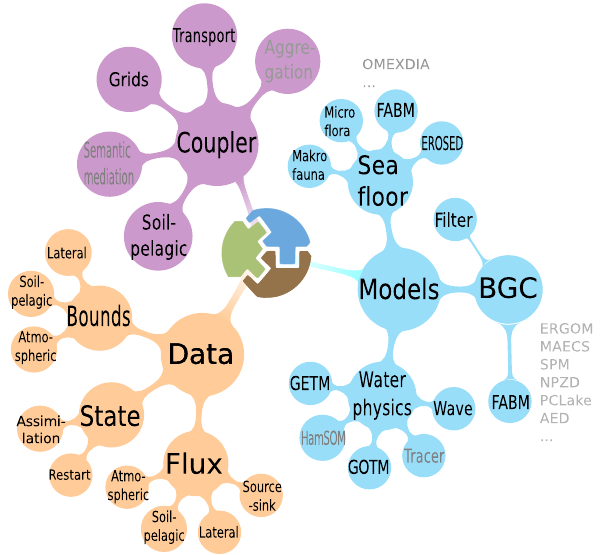
Figure 4. Modular components of MOSSCO. The blue branch col- lects newly created sub-models and components that wrap around legacy codes; the violet branch collects coupling functionalities and the orange branch the input–output